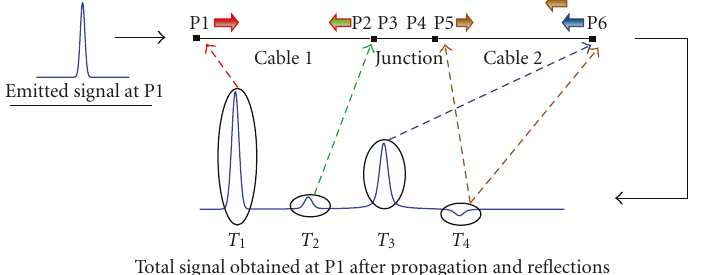
Figure 8: T 1 = emitted pulse at P1; T 2 = pulse resulting from the reflection at junction point P2 (cable1/junction) of T 1 ; T 3 = pulse resulting from the reflection at end of line point P6 of T 1 − T 2 ; T 4 = pulse resulting from the reflection at P6 of the part of T 3 coming from its reflection at junction point P5 (cable2/junction).